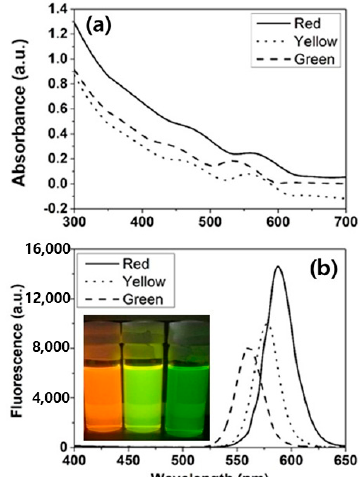
Figure 2. ( a ) UV-Vis absorption; and ( b ) photoluminescence spectra of red, yellow and green QDs. Inset of ( b ) shows the optical images under the UV lamp. A schematic of the three-electrode configuration used in the electrochemical measurements of the QDs is given in Figure 3a. The photo-electrochemical properties of the QDs were determined by CV investigations, which were carried out in the presence and absence of light illumination. The ITO substrates on which the QDs were deposited were employed as the working electrodes. Atomic Force Microscopy (AFM) was used to image the QD arrays, deposited on the ITO electrode. Figure 3b shows that the red QDs are well distributed along the ITO substrate as a monolayer. The image also indicates that individual QDs are well separated, not aggregated; shows the distribution of green and yellow QDs on the ITO. A Pt foil and Ag/AgCl in KCl were used as counter and reference electrodes, respectively.